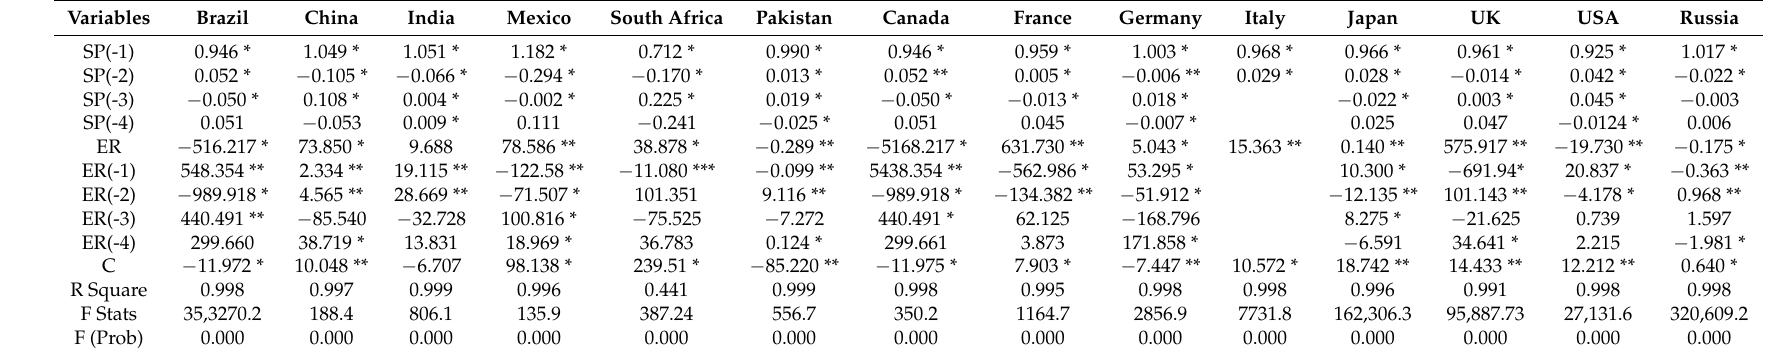
Table 3. Autoregressive distributed lag (ARDL) dependent variable: stock price.